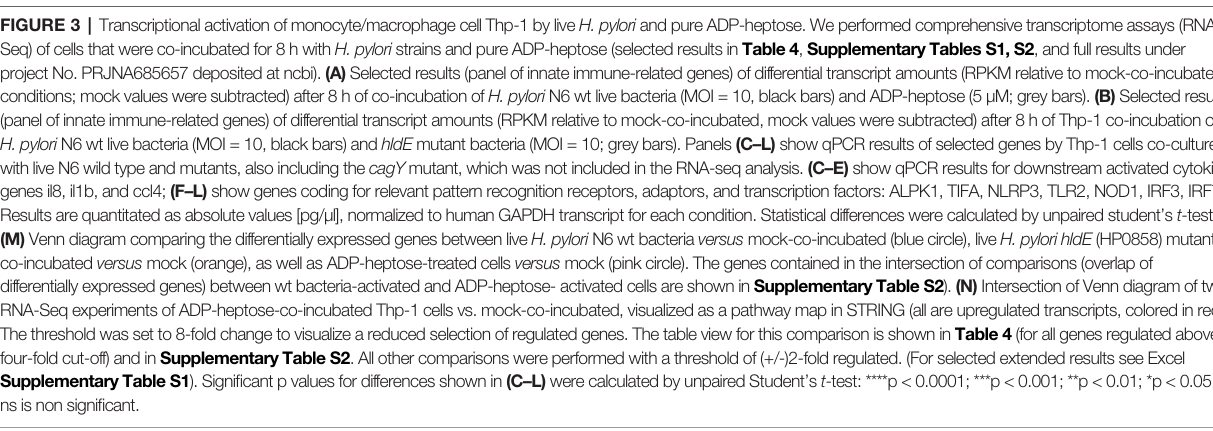
FIGURE 3 | Transcriptionalactivationofmonocyte/macrophagecellThp-1bylive H. pylori andpureADP-heptose.Weperformedcomprehensivetranscriptomeassays (RNA- Seq) ofcells thatwereco-incubatedfor 8hwith H.pylori strainsandpureADP-heptose(selectedresultsin Table4 , SupplementaryTablesS1, S2 ,andfullresultsunder projectNo.PRJNA685657 depositedatncbi). (A) Selectedresults(panelofinnateimmune-relatedgenes) ofdifferentialtranscriptamounts(RPKMrelativeto mock-co-incubated conditions;mockvaluesweresubtracted) after8 hofco-incubationof H.pylori N6wtlivebacteria(MOI=10, blackbars)andADP-heptose(5 µM;greybars). (B)